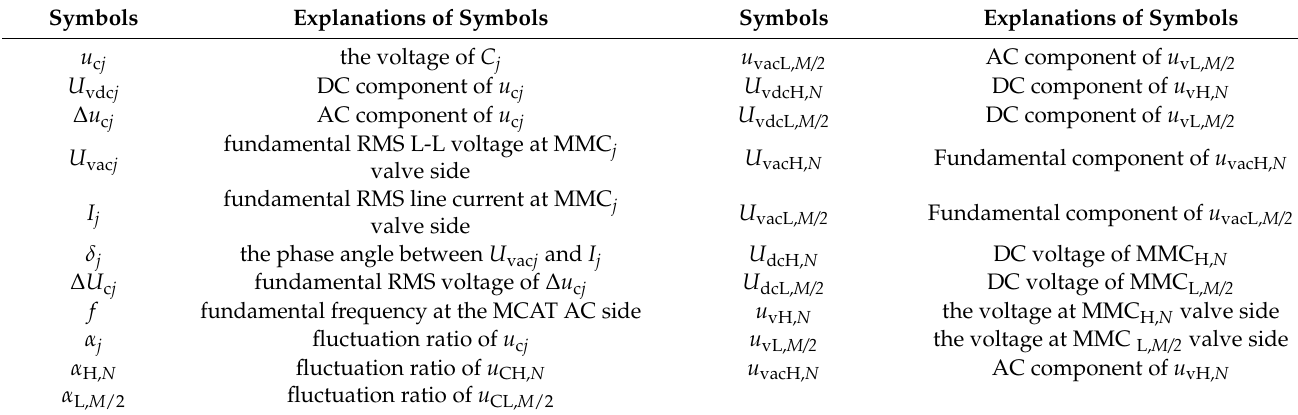
Table A1. Explanations of the abbreviations and symbols used in this section. Symbols Explanations of Symbols Symbols Explanations of